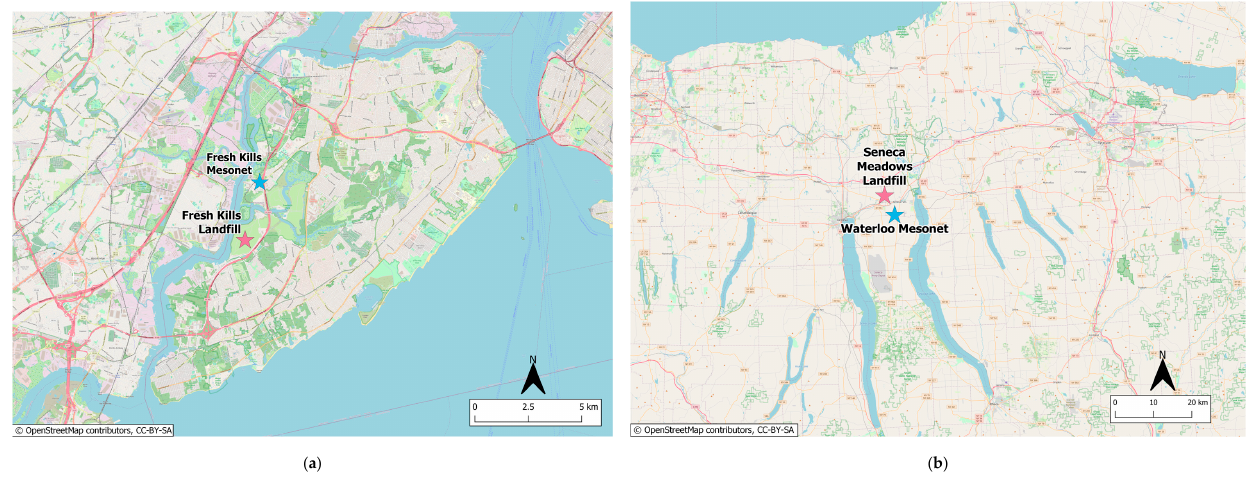
Figure 3. ( a ) Locations of Fresh Kills Landfill on Staten Island, NY, in relation to the New York State Fresh Kills Mesonet Station. The Mesonet site is stationed about 2.5 km north of the landfill. ( b ) Site location of Seneca Meadows Landfill in Waterloo, NY. The New York State Waterloo Mesonet site is located about 5 km southeast of the